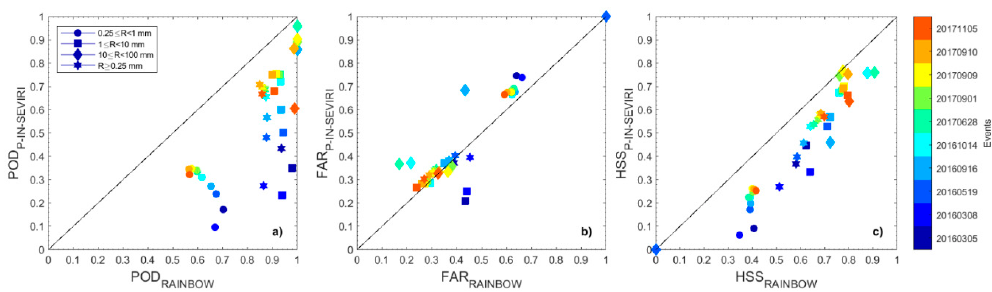
Figure 12. Comparison of ( a ) POD, ( b ) FAR, and ( c ) HSS scores calculated for RAINBOW and P-IN-SEVIRI outputs with respect to the GRISO data (taken as reference) on a regular 0.25 ◦ × 0.25 ◦ grid for 10 case studies. A minimum cumulated rain threshold is set at 0.25 mm and three di ff erent intervals of cumulated rain are considered: light 0.25–1 mm, moderate 1–10 mm, and heavy 10–100 mm. Figure 13a shows that ME RAINBOW and ME P-IN-SEVIRI are very similar for heavier precipitation intensity, while ME RAINBOW and ME P-IN-SEVIRI assume values around 0 mm and slightly negative,